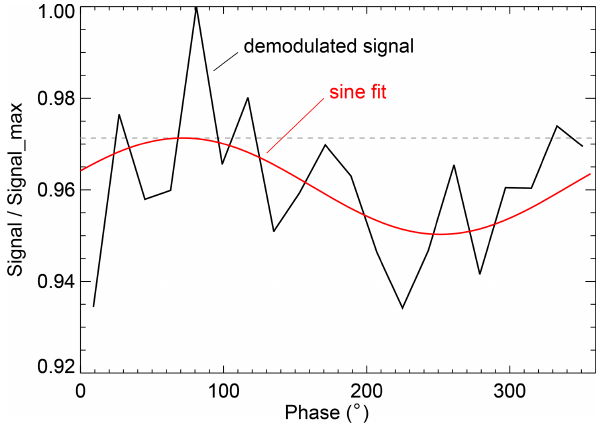
Figure 5. Example of a demodulated conscan signal acquired with CORAL. The dashed line indicates the mean signal that would be obtained in the case of a perfect beam overlap and no modulation.